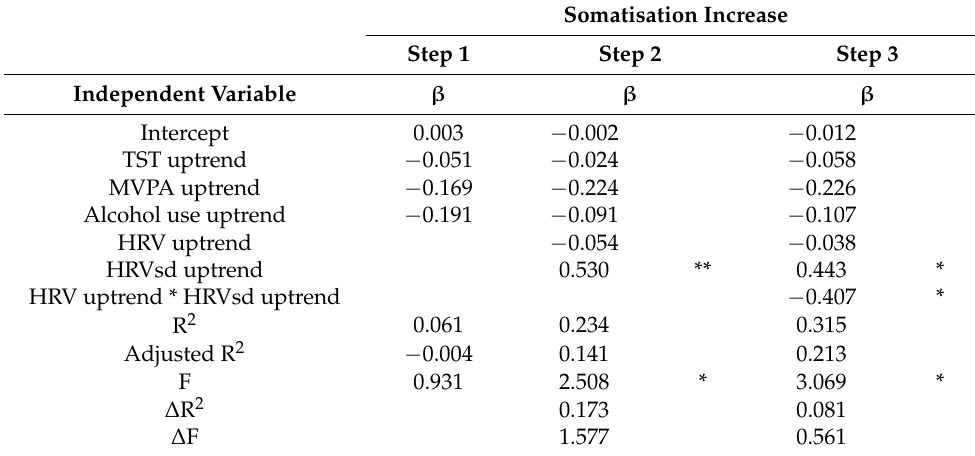
Table 3. Hierarchical multiple regression model for five-week somatisation increase.